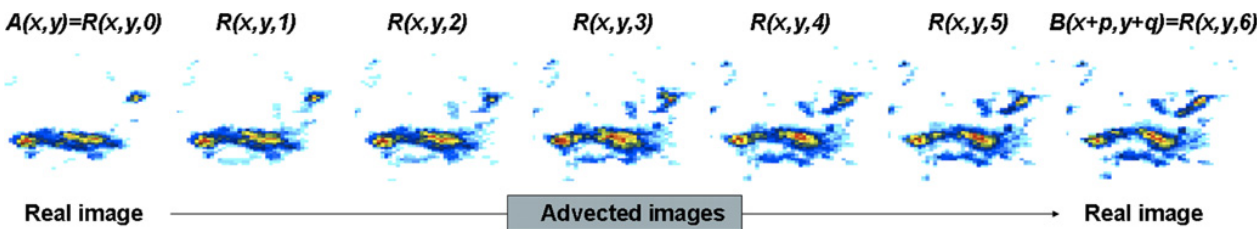
(a) Division of the first image into templates (solid lines) and search area (dashed line) corresponding to the central template. Fig. 6. Example of templates in the second image for the cross-correlation technique and the displacement vector obtained. Both pictures, (a) and (b) , are extracted from Dransfeld et al. (2006).